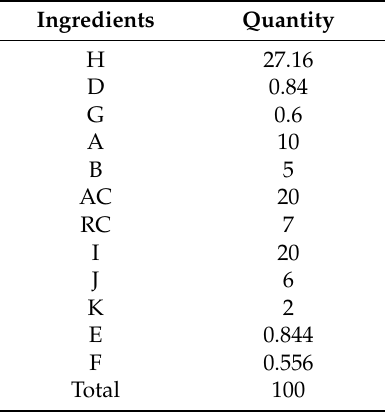
Table 10. Composition of the newly developed latex paint (in percentage/100 g).